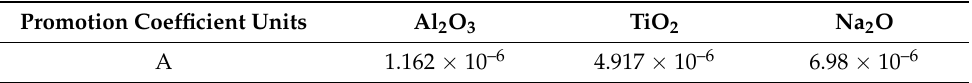
Table 3. Promotion coefficients of the dissolution rate of lime with different additives